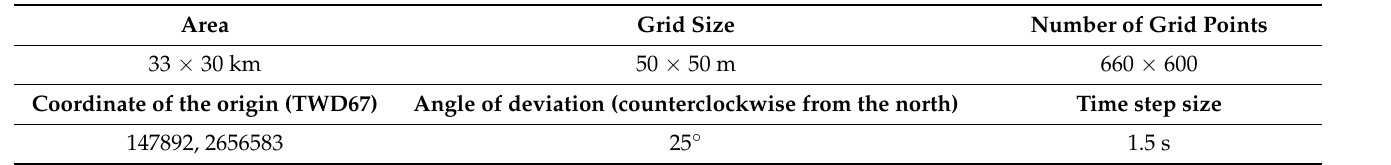
Figure 3. Topographical settings of the model. Table 1. Calculation conditions for model